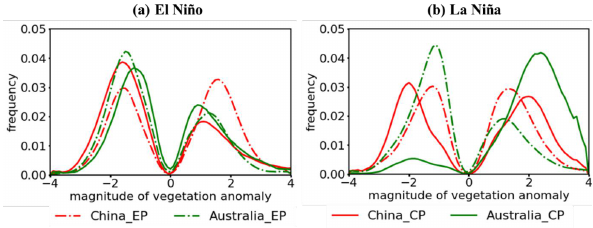
Figure 3 . Frequency distribution of magnitude of vegetation anomalies during different ENSO conditions associated with (a) El Niño and (b) La Niña events of type EP (dashdotted) and CP